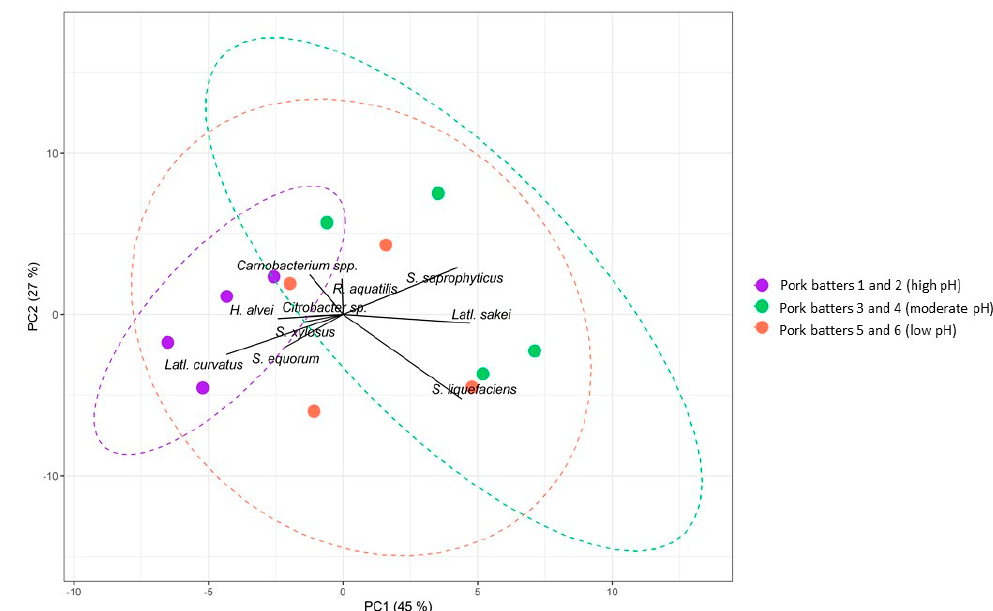
Figure 2. Centred principal component analysis (PCA) biplot based on Bray–Curtis dissimilarity scores of the bacterial community structures, with factor loadings, of pork fermentation processes. Only factor loadings with an absolute value above 1 were considered. Colours indicate different sample groups characterized by high pH (purple), moderate pH (orange), or low pH (green). The proportion of variance for every PC is indicated between brackets. The dotted lines represent 90% normal confidence ellipses for the sample groups.